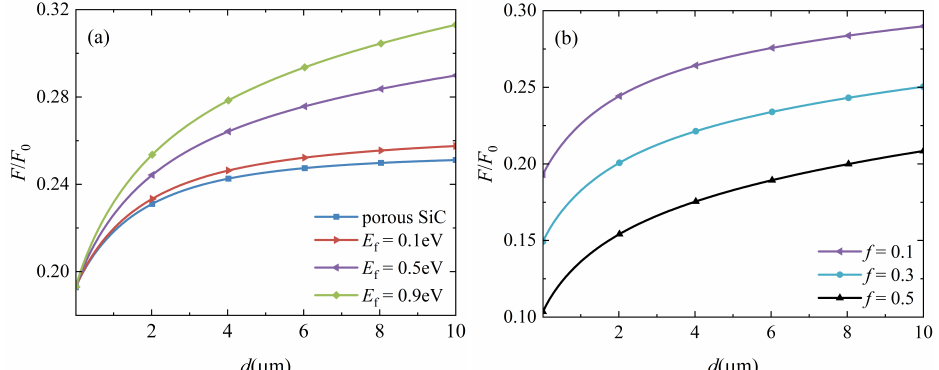
Figure 6. Dependence of the Casimir force on the separation d . ( a ) The case of identical porous SiC is indicated by the blue line, while other lines represent the case of graphene-covered porous SiC at different Fermi levels. The filling factor has been set to f = 0.1. ( b ) The case of graphene-covered porous SiC for different filling factors with a fixed Fermi level E f = 0.5 eV.